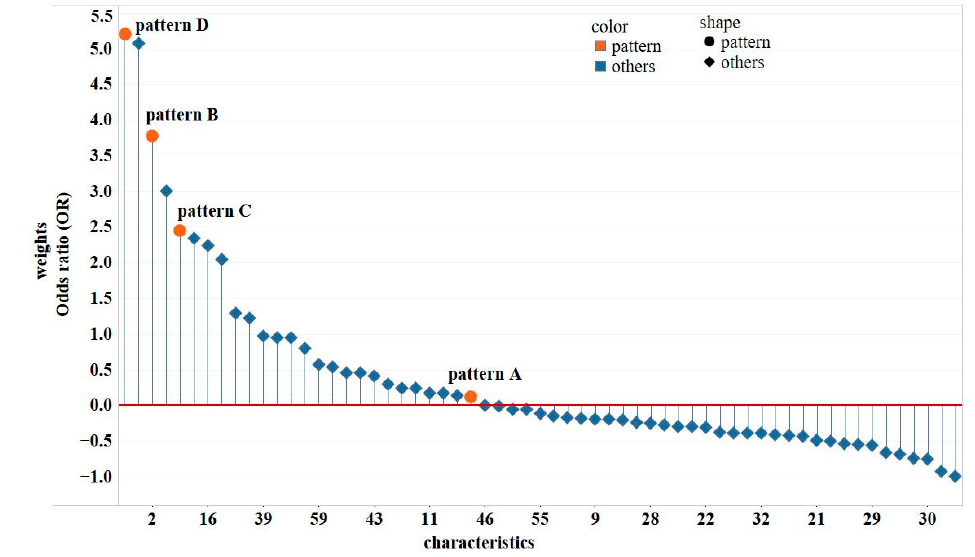
Figure 10. Important factors for risk prediction.